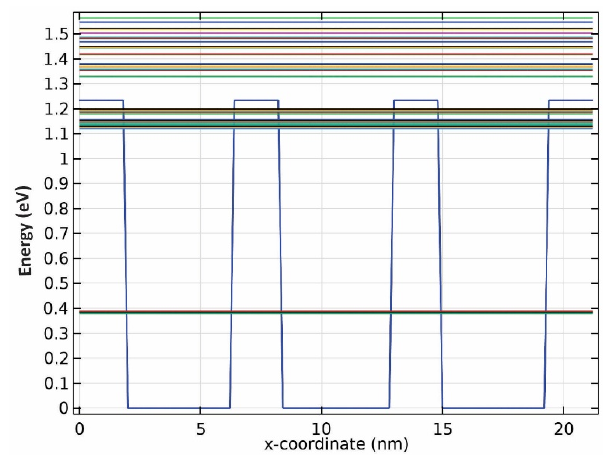
Figure 4. Energy band diagram for QDs with R2 radii.